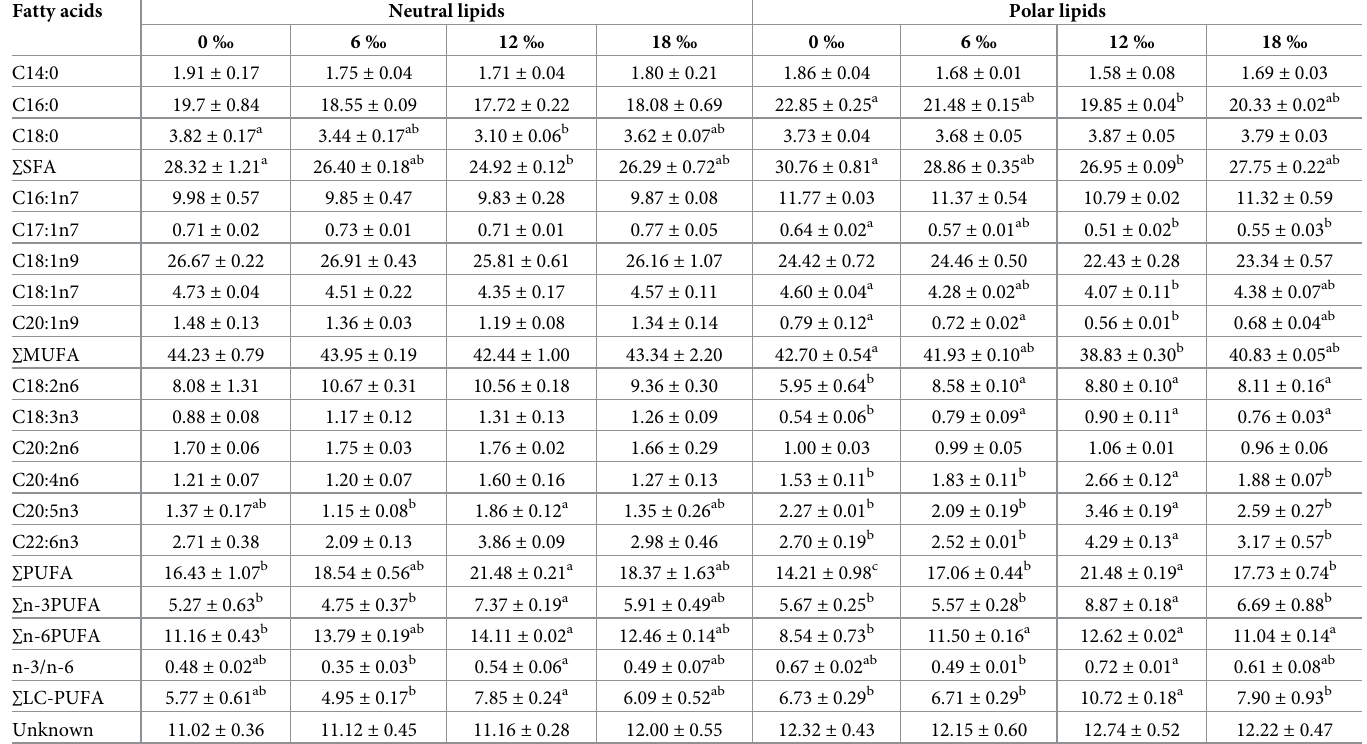
Table 5. The principal fatty acid profiles (% total fatty acids) of the neutral lipids and polar lipids in the hepatopancreas of adult female E . sinensis . Fatty acids